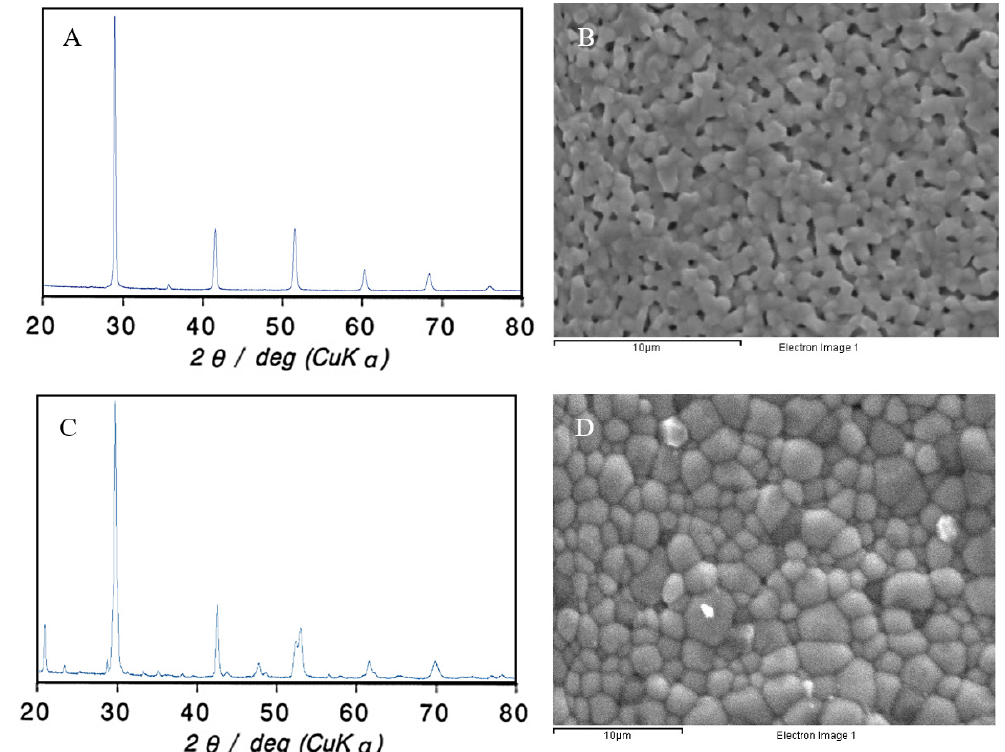
Figure 3. SEM and DRX characterization: ( A ) XRD pattern of BaCeZrY ceramic pellet; ( B ) sintered BaCeZrY ceramic pellet surface SEM micrograph; ( C ) XRD pattern of SrCeZrYb ceramic pellet; ( D ) sintered SrCeZrYb ceramic pellet surface SEM micrograph.